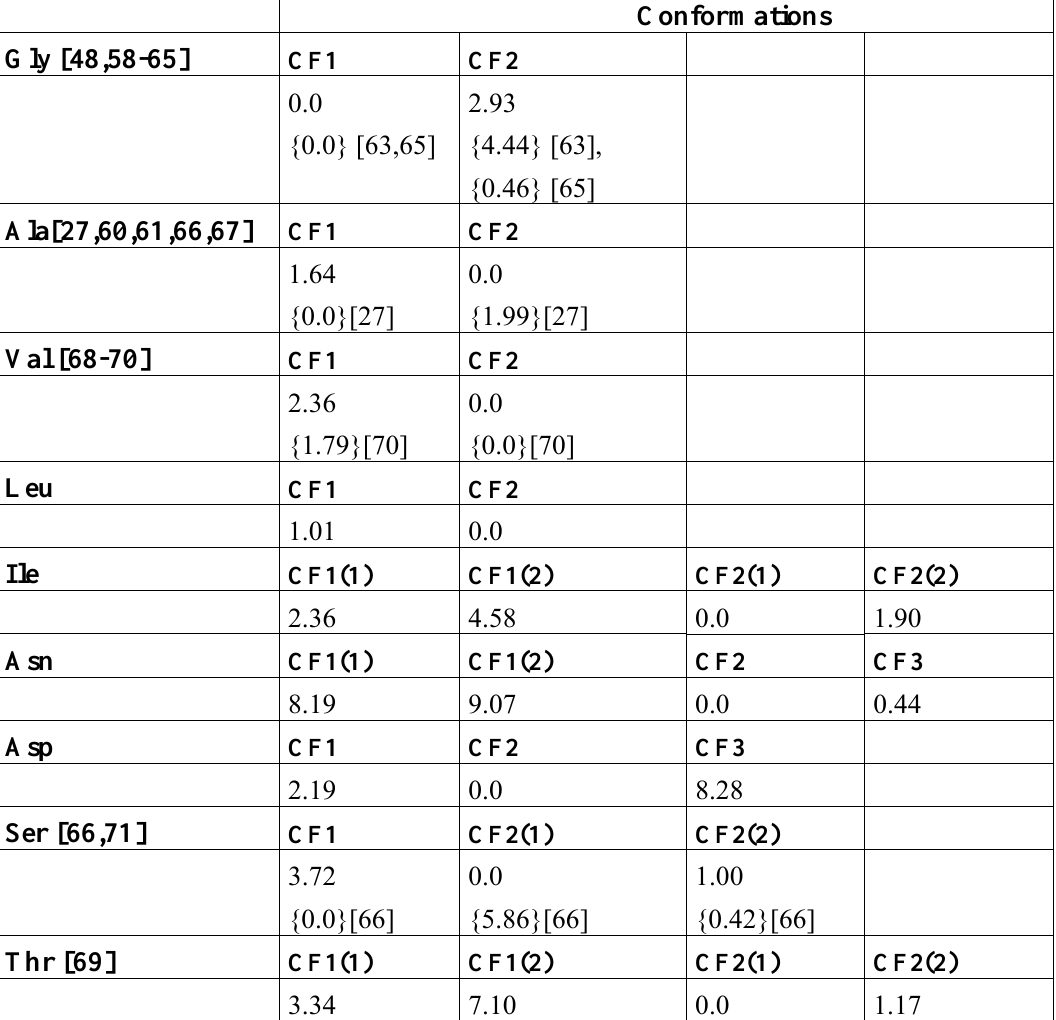
Table 3: Relative energies (kJ/mol) for the chosen conformers optimized at the B3LYP level. In {} are given the corresponding values taken from the more